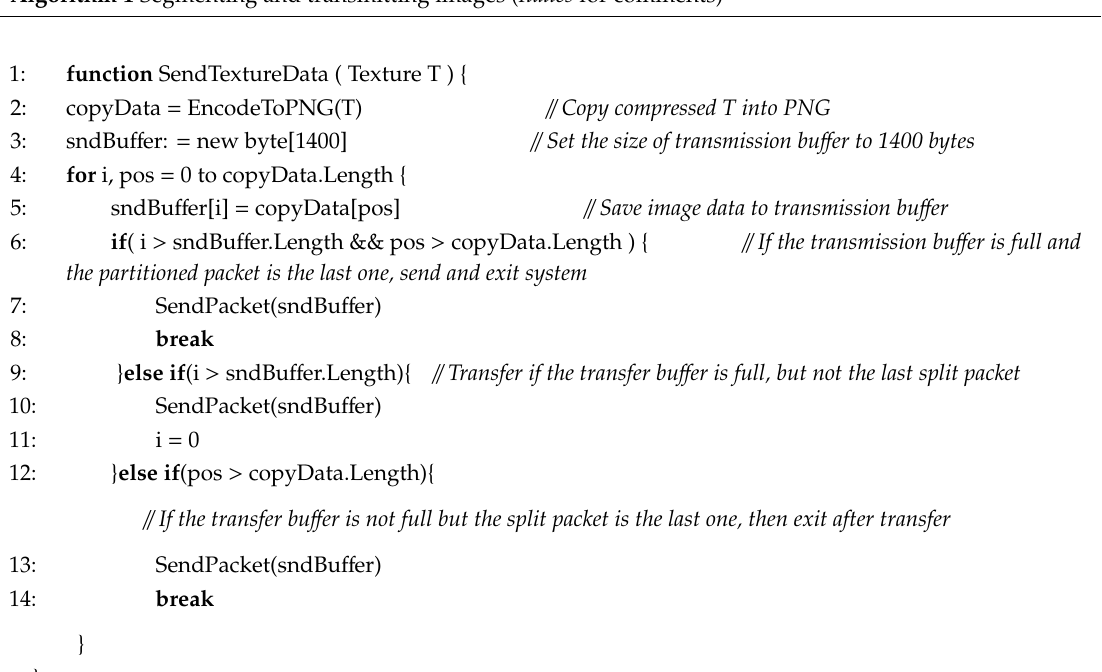
Algorithm 1 Segmenting and transmitting images ( Italics for